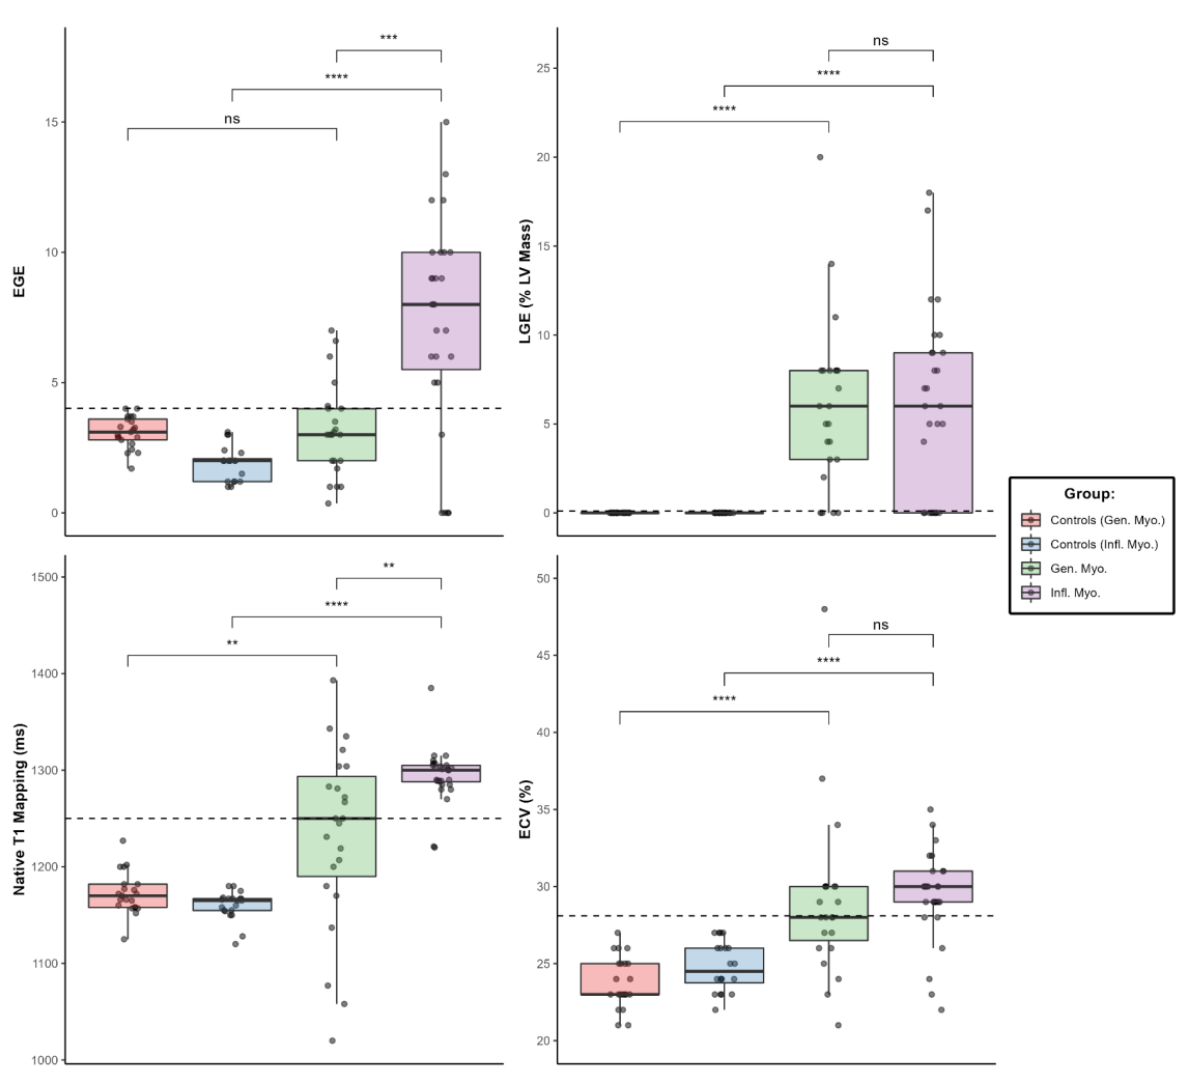
Figure 1. Boxplots and individual data points for T1-based CMR indices. p -values for individual comparisons are presented numerically in the corresponding tables (Tables 1 – 3). Cut-off points for defining normal values are denoted with dashed lines for each measurement. CMR: cardiovascular magnetic resonance; EGE/LGE: early/late gadolinium enhancement, ECV: extracellular volume fraction. ns: not significant; ** p ≤ 0.01; *** p ≤ 0.001, **** p ≤ 0.0001.